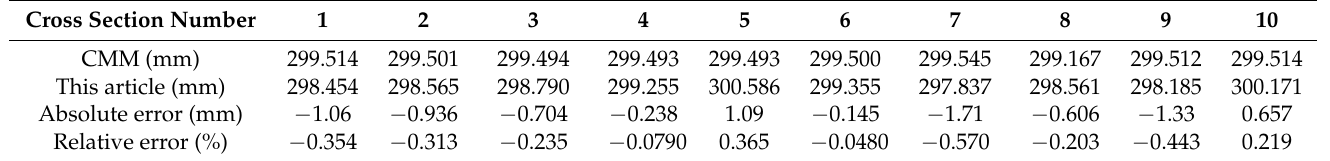
Table 1. Validation-experiment results.